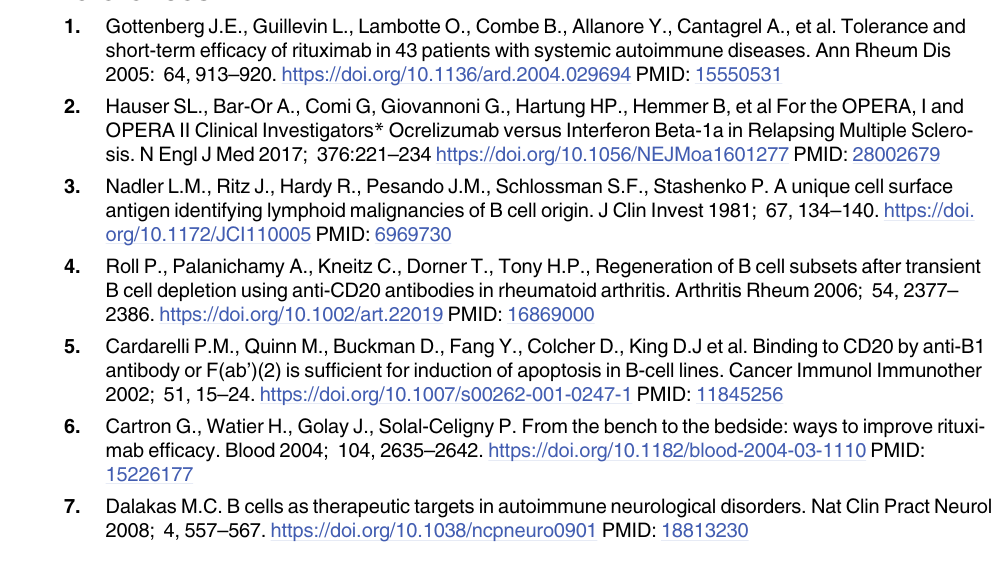
S1 Fig. Rituximab data excel